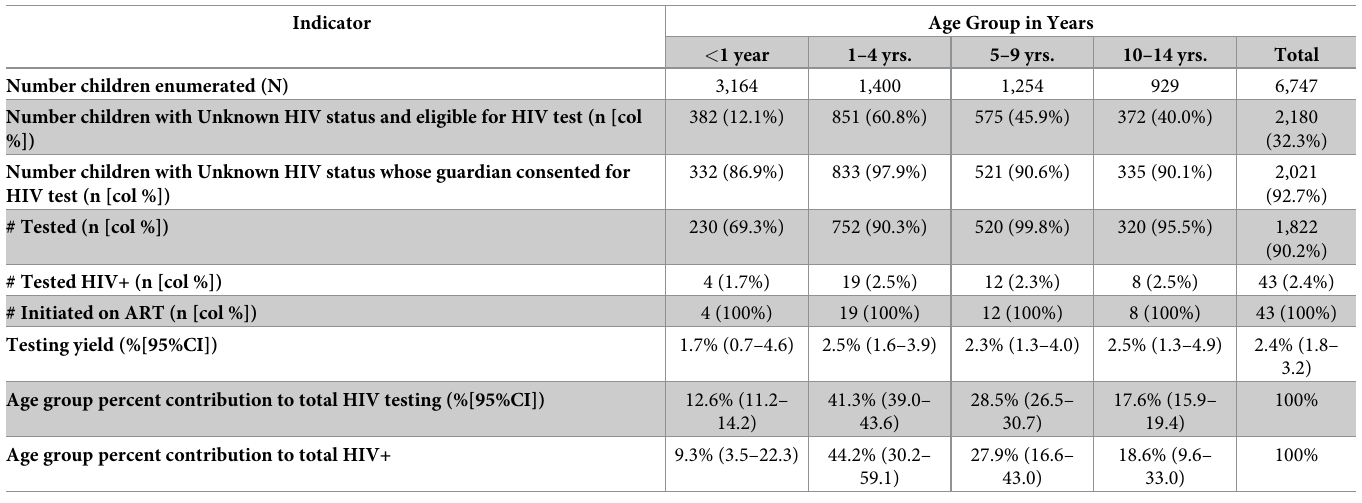
Table 1. HIV testing pediatric cascade by age group across all PICF pilot sites.